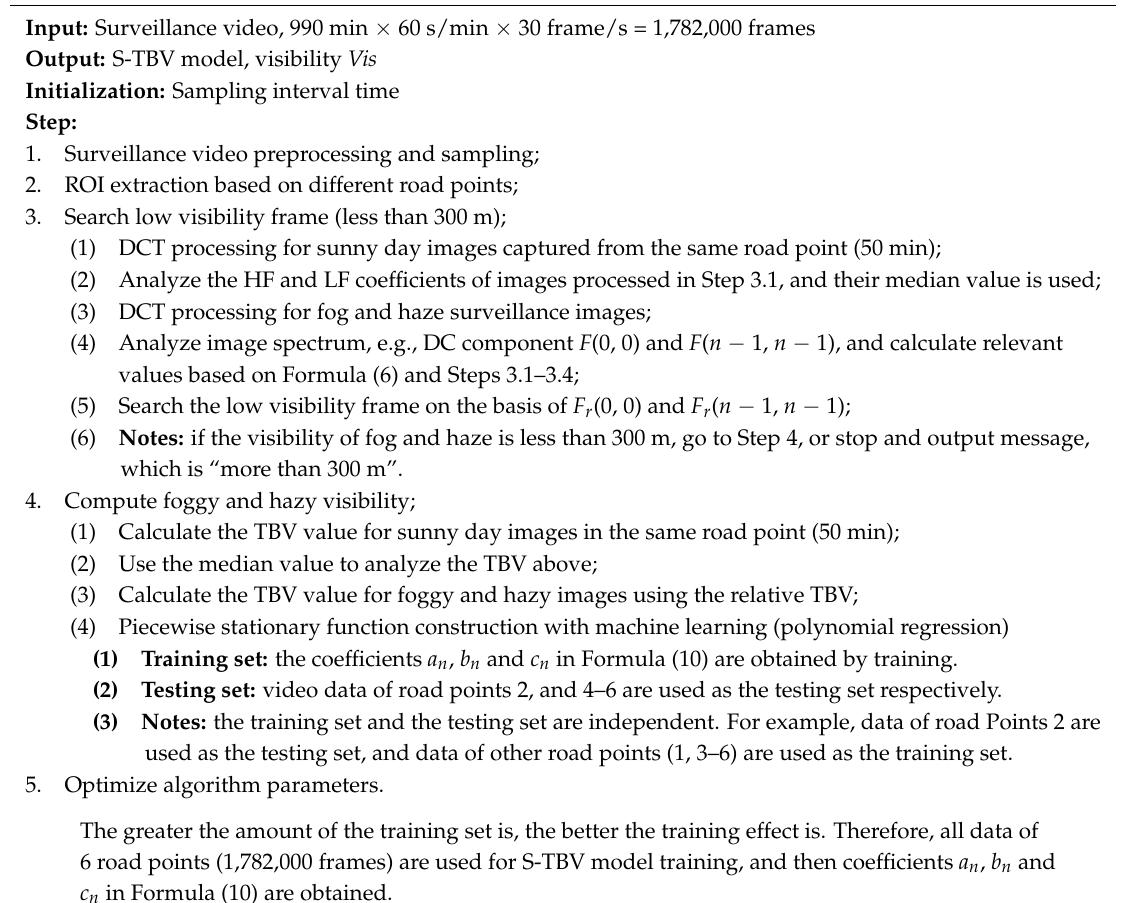
Algorithm 1: Total bounded variation approach to low visibility